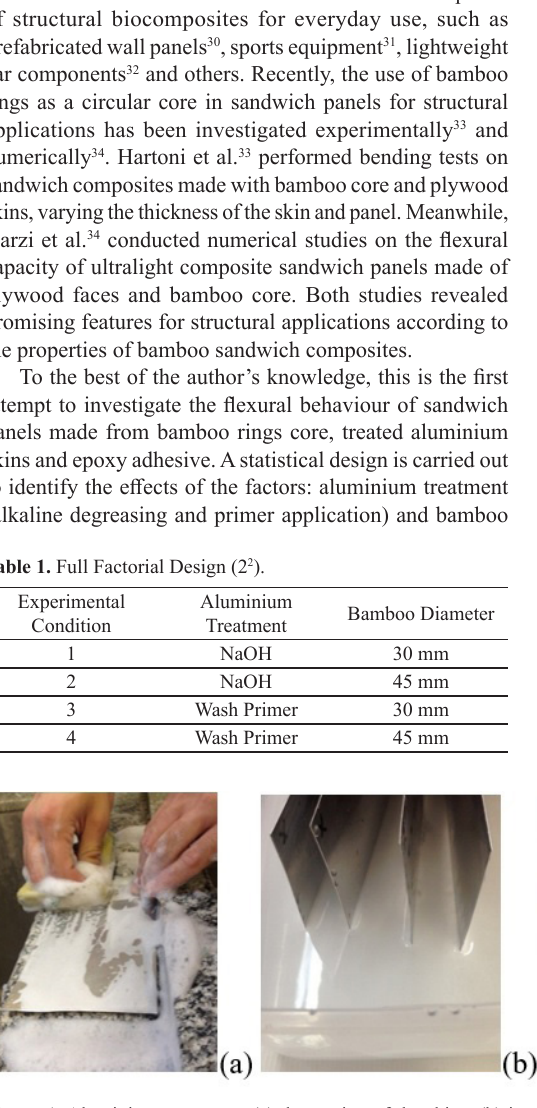
Figure 1. Aluminium treatment: (a) degreasing of the skins, (b) immersion in the NaOH solution, (c) pulverization with wash primer and (d) tensile